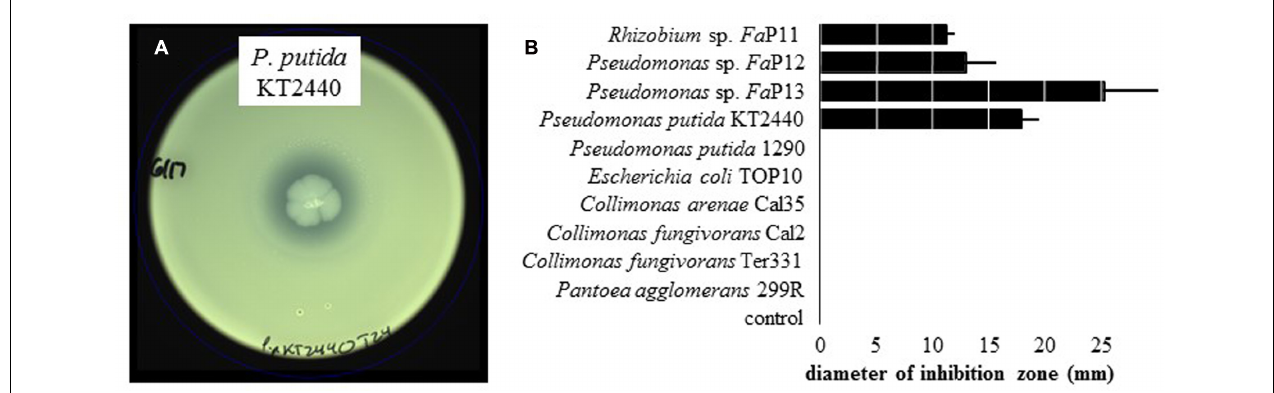
FIGURE 3 | Inhibition of X. fragariae by bacterial antagonists. (A) : WBN agar overlay plate showing the absence of X. fragariae growth near the point-inoculated colony of P. putida KT2440 in the center of the plate, after 22 h of incubation. (B) : shown is the average diameter of the zone of X. fragariae Fa P29 inhibition produced by the bacterial strains listed, after 22 h. Error bars represent the standard deviation showing the variation between three independent experiments.